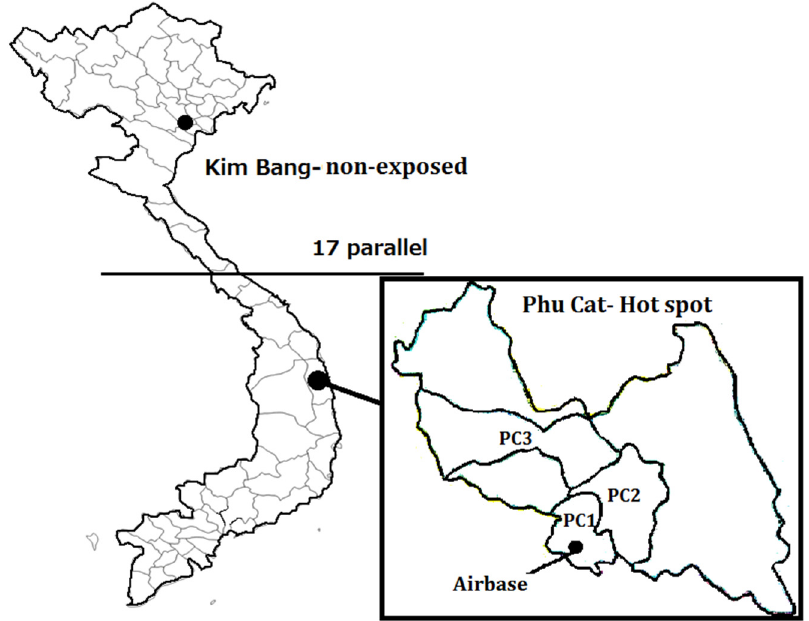
Figure 1. Study areas in Vietnam. The 17 parallel is the dividing line between North Vietnam and South Vietnam, as established by the 1954 Geneva Conference. PC1, PC2, and PC3 represent three subareas in the Phu Cat hotspot.